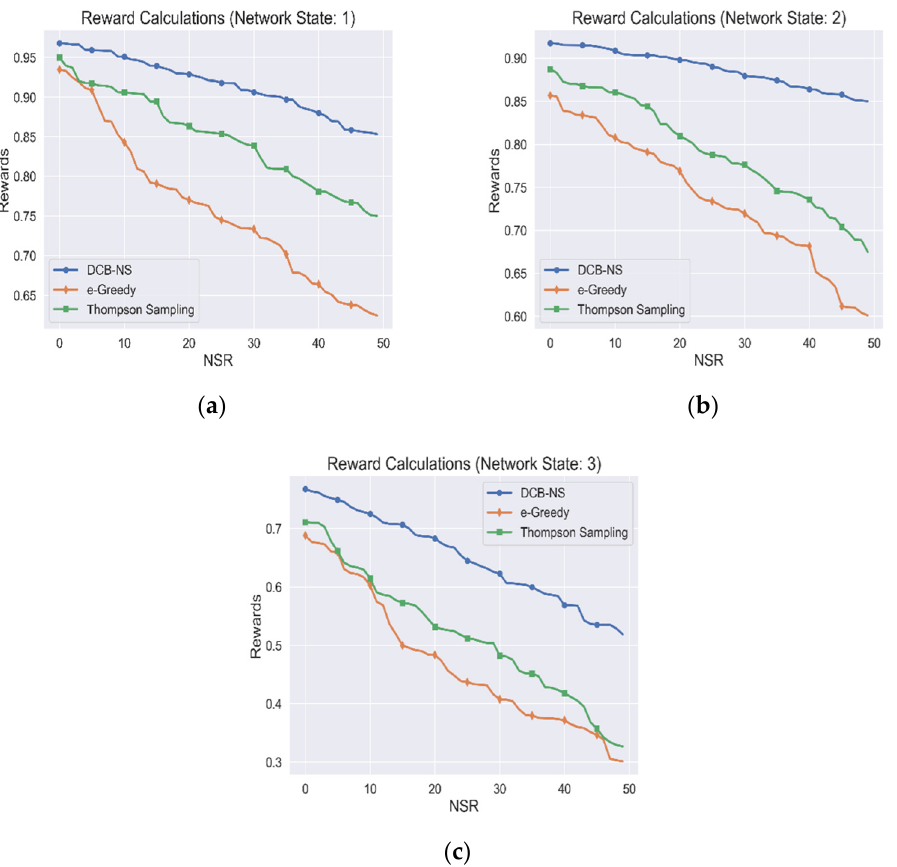
Figure 3. Cumulative Agent Rewards for ( a ) Network State 1, ( b ) Network State 2, and ( c ) Network State 3.